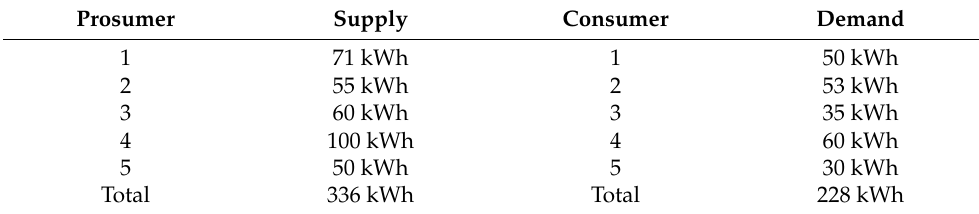
Table 5. Supply and demand presented by prosumers and